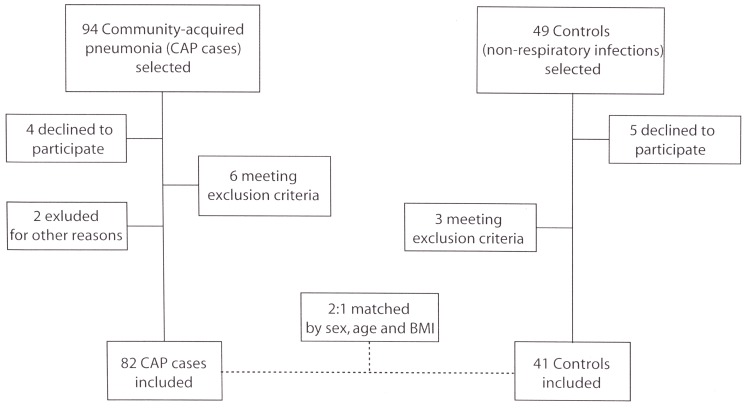
Study flowchart depicting recruitment.